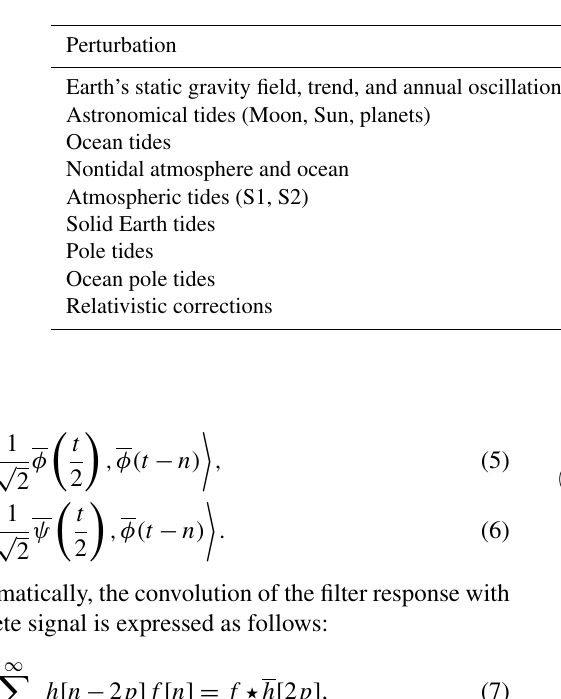
Table 1. Summary of ITSG-Grace2016 force models.